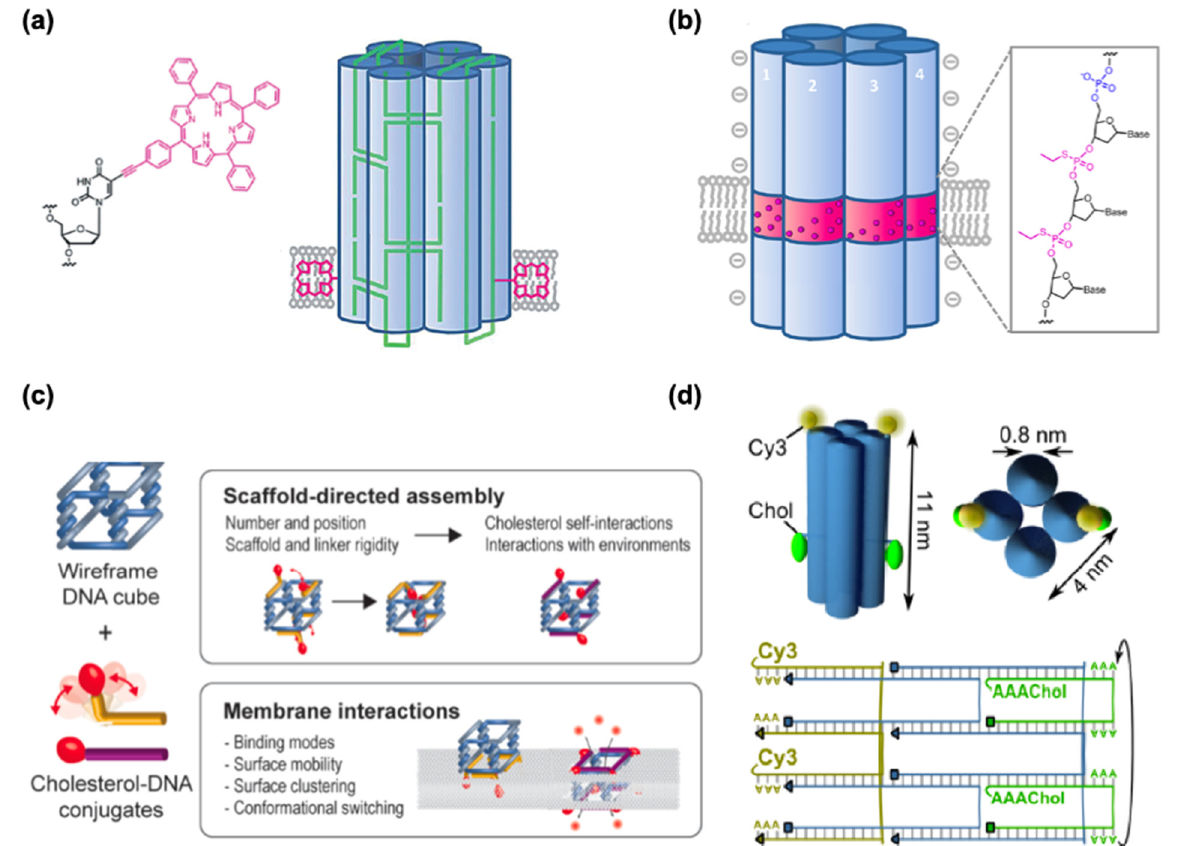
Figure 9. DNA nanostructures interact with the cell membrane. ( a ) DNA-nanopore carrying porphyrin-based lipid anchors. Deoxyuridine bonded to tetraphenylporphyrin (TPP) through an acetylene linkage at the 5 position of nucleobase (Left) A DNA nanopore composed of six interconnected duplexes, drawn as cylinders. (Green—DNA oligonucleotides, Magenta—Porphyrin tags anchoring the DNA nanopore into the lipid bilayer.) Adapted with permission from [148]. Copyright © 2022, The Authors published by Wiley-VCH Verlag GmnH & Co. KGaA. ( b ) A DNA nanopore composed of six interconnected duplexes represented as cylinders with an external face featuring a membrane-spanning hydrophobic belt (magenta) where the conventional phosphate of the DNA backbone is substituted with charge-neutral phosphorothioate-ethyl groups. Adapted with permission from [153]. Copyright © 2022, American Chemical Society. ( c ) A DNA cube with cholesterol anchors in lipid membrane mimicking membrane protein. Adapted with permission from [150]. Copyright © 2022, American Chemical Society. ( d ) Schematic side view (top left) and top view (top right) of the DNA-tile structure composed of four interconnected duplexes represented as cylinders. (Green—cholesterol anchors, Yellow—Cy3-tags) and pathways of eight tiles forming the four duplexes and positions of the Cy3 and cholesterol modifications (Bottom) Adapted with permission from [149]. Copyright © 2022, American Chemical Society. Table 4. Designs and structures of DNA nanopores.